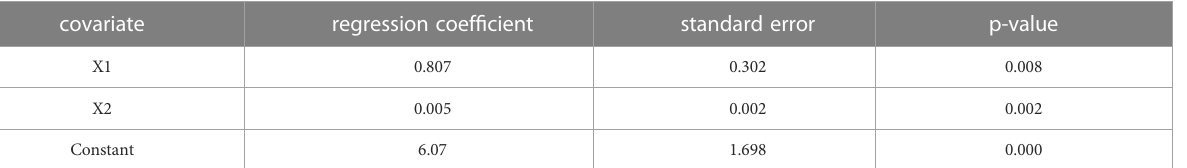
TABLE 5 Results of binary logistic regression using